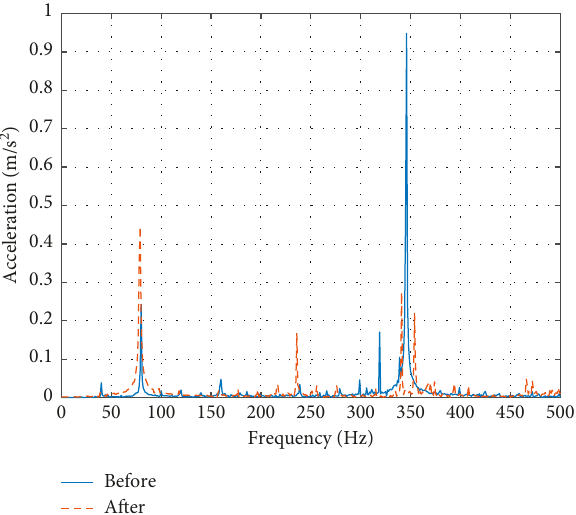
Figure 10: Vibration signals before and after performing structural optimisation.